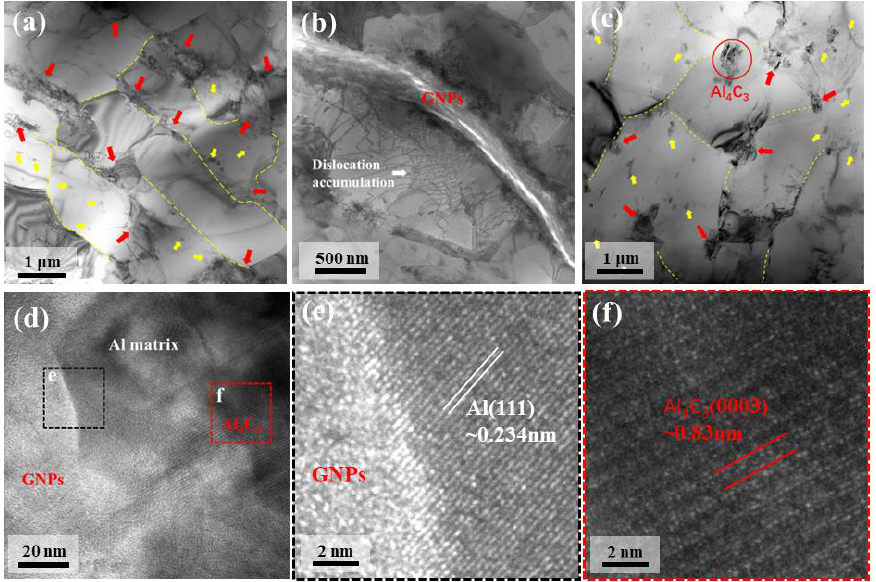
Figure 14. TEM images of GNP/Al composites: ( a – c ) distribution of graphene; ( d , e ) HRTEM images of composites showing the interface between GNP and Al; ( f ) Al 4 C 3 in matrix.